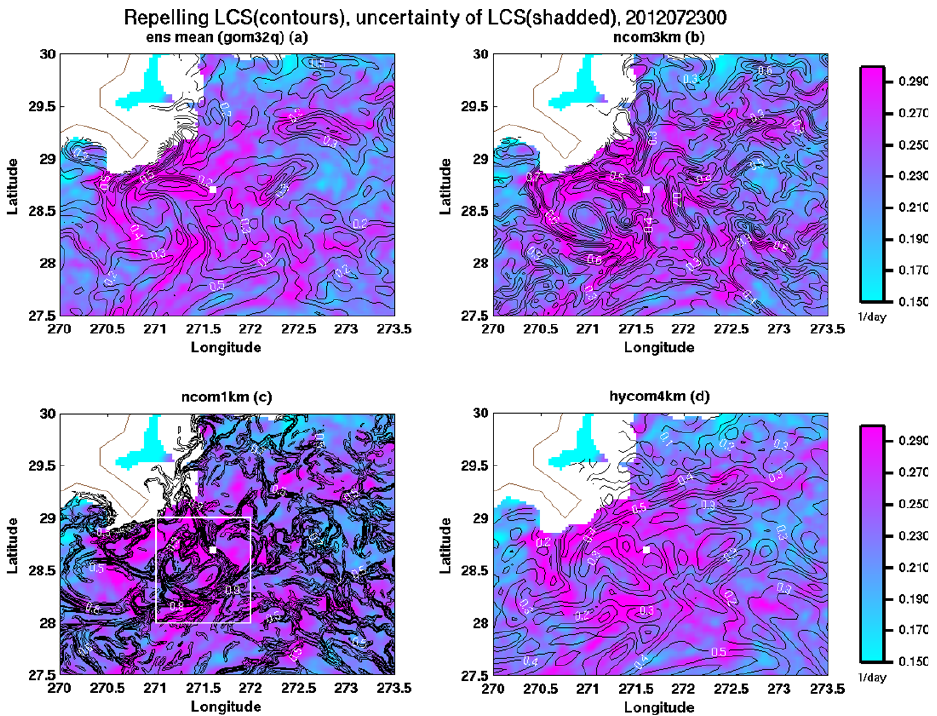
Fig. 12. The same as Fig. 11, but for a smaller domain around the GLAD drifters area indicated by the white rectangle in Fig. 11. The DWH location is indicated by the white